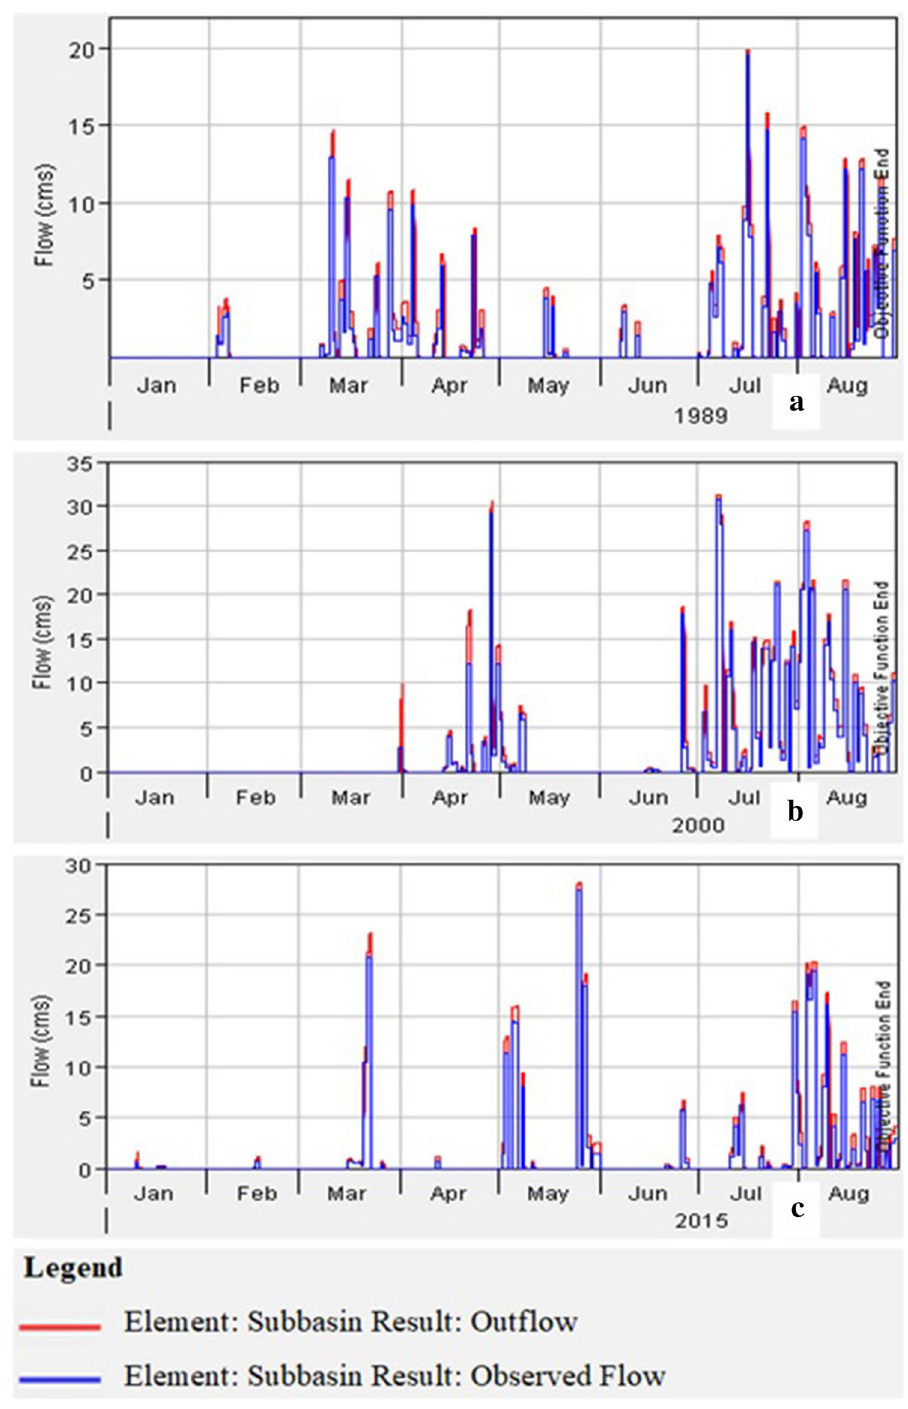
Fig. 6 Calibration of HEC-HMS model (01 Jan to 31 Aug) ( a